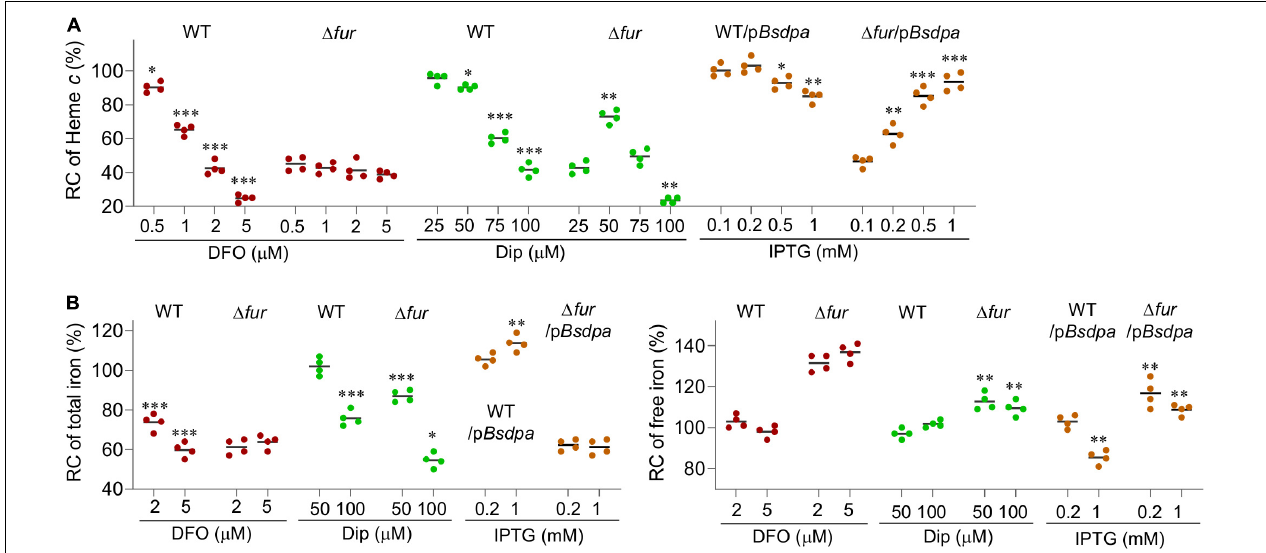
FIGURE 7 | The free iron content determines the physiological impacts of the Fur loss. (A) Suppressing effects of iron chelators on the fur deletion based on cyt c biosynthesis. Dip, 2,2-dipyridyl. p BsdpaAB , B. subtilis dpaAB gene under the control of P tac within pHGE-Ptac. (B) Relative concentrations (RC) of total and free iron in WT and (cid:49) fur strains. Cultures of indicated strains entering the stationary phase were collected and their total iron and free iron contents were determined. The averaged levels of WT were set to 100%. Con, no chelator; DFO-2 and -5, DFO at 2 and 5 µ M; Dip-50 and -100, dipyridyl at 50 and 100 µ M; IPTG-0.2 and -1, p BsdpaAB with IPTG 0.2 and 1 mM. Asterisks indicate statistically significant differences of the value compared to that of the WT and between values linked by bracket (* P < 0.05; ** P < 0.01; *** P < 0.001). Experiments were performed at least three times, and data were presented as means ± SEM or by representative